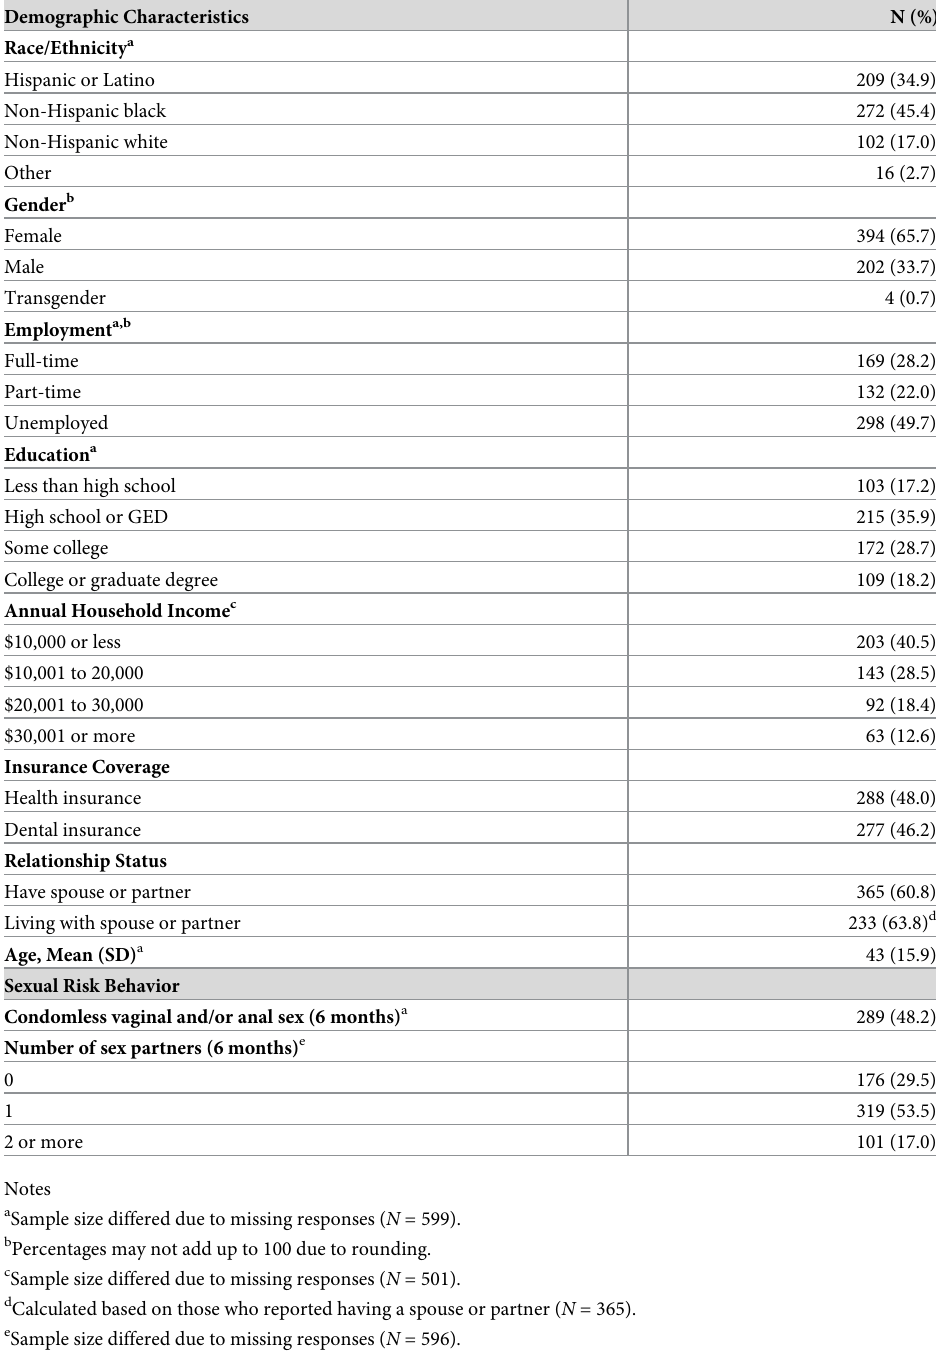
Table 1. Demographic characteristics for patients receiving dental care at 2 federally qualified healthcare centers, South Florida, 2014–2015 ( N =